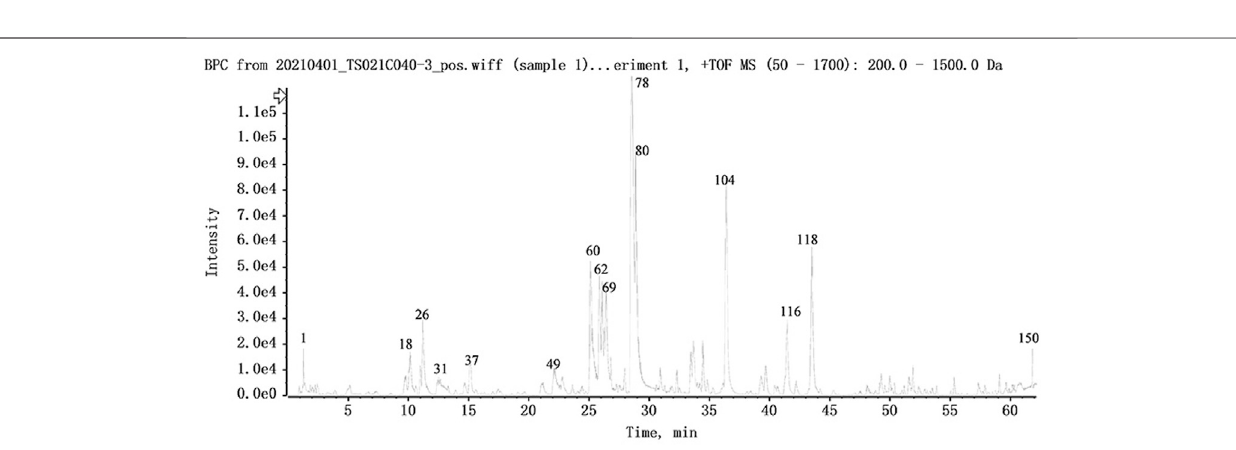
FIGURE 5 | The base peak intensity chromatogram of NFPX by UPLC-HRMS in positive ion mode.